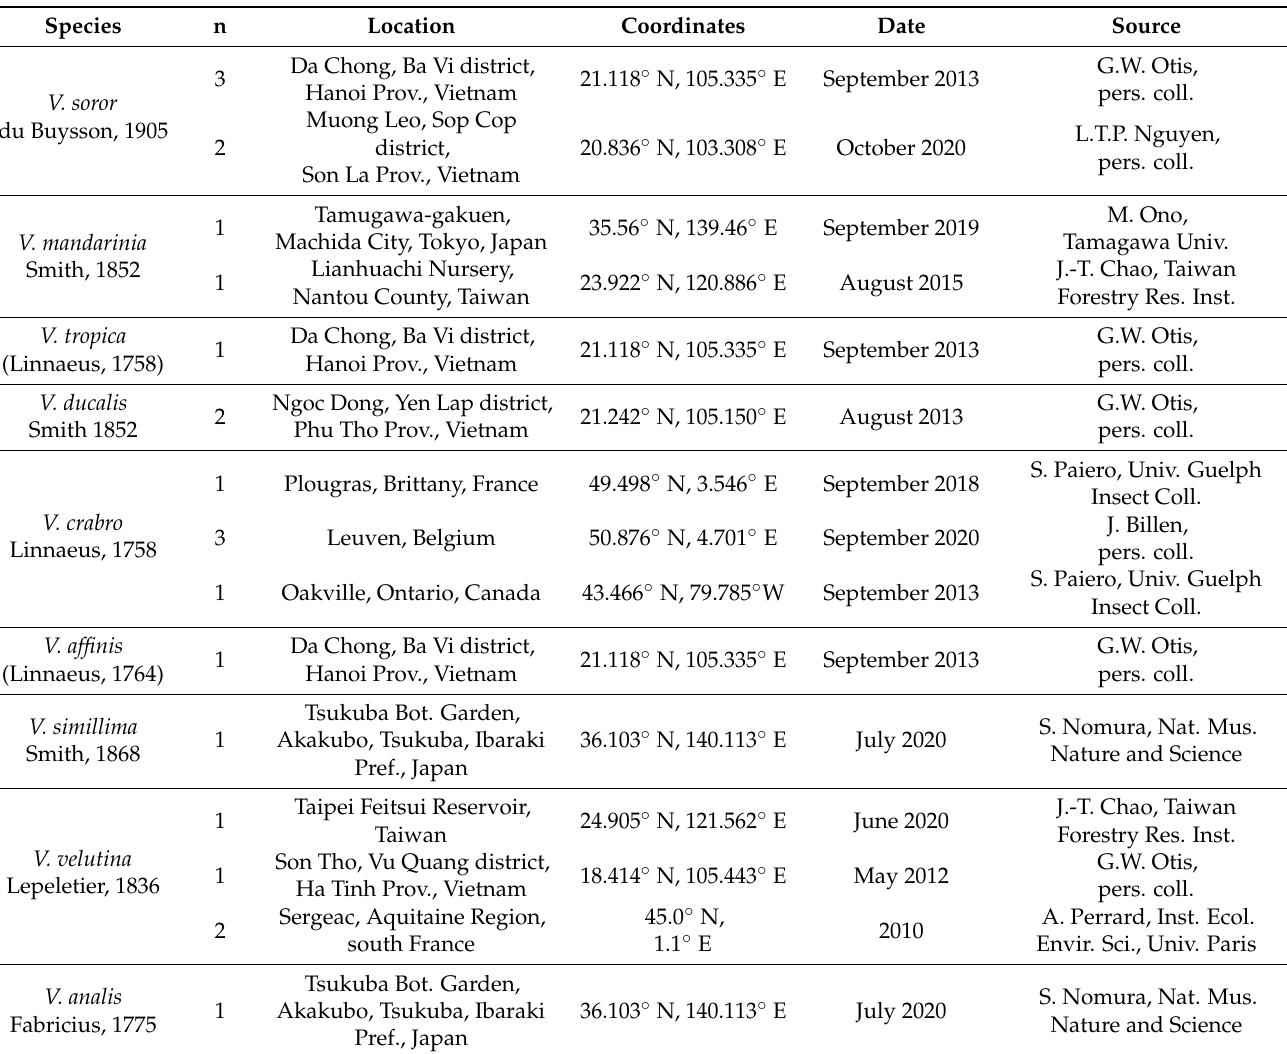
Table 1. Sources of worker specimens for nine Vespa species, with available details about their locations, geographical coordinates, and collection dates (month/year if